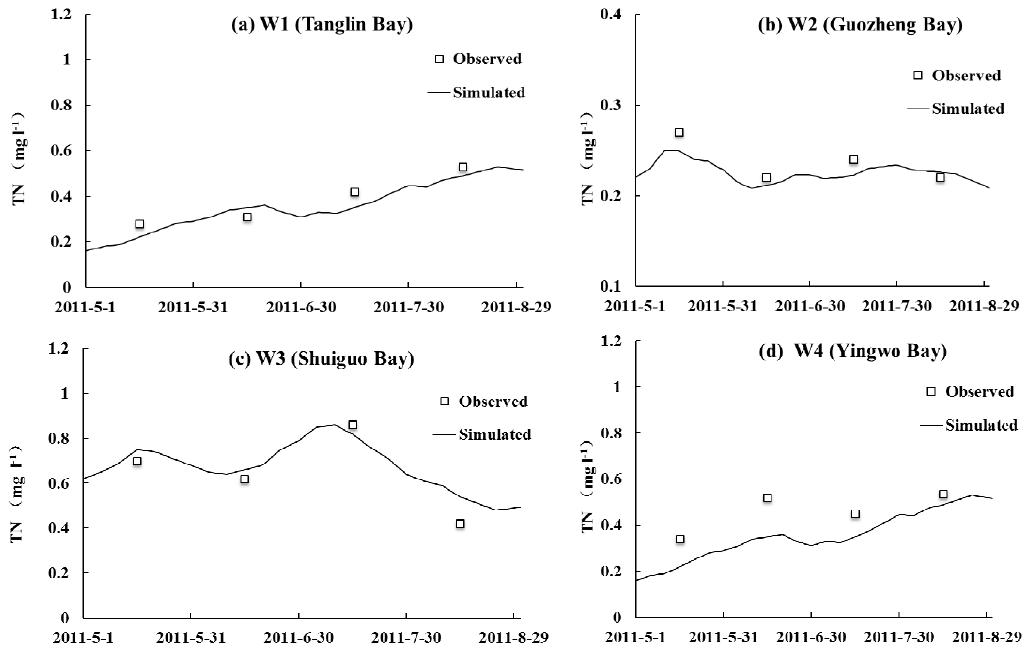
Figure 10. Comparison of simulated and observed TN at four bays: ( a ) Tanglin Bay; ( b ) Guozheng Bay; ( c ) Shuiguo Bay; and ( d ) Yingwo Bay.